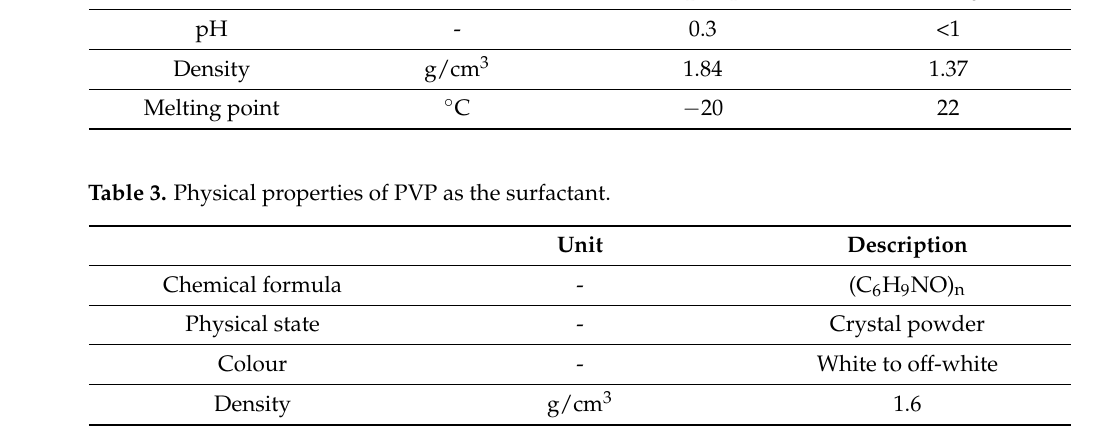
Table 3. Physical properties of PVP as the surfactant.